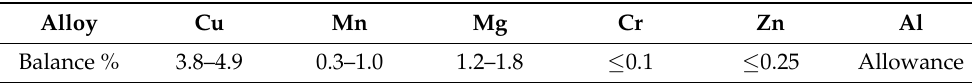
Table 1. Chemical composition of the AA2024 aluminum alloy [9].